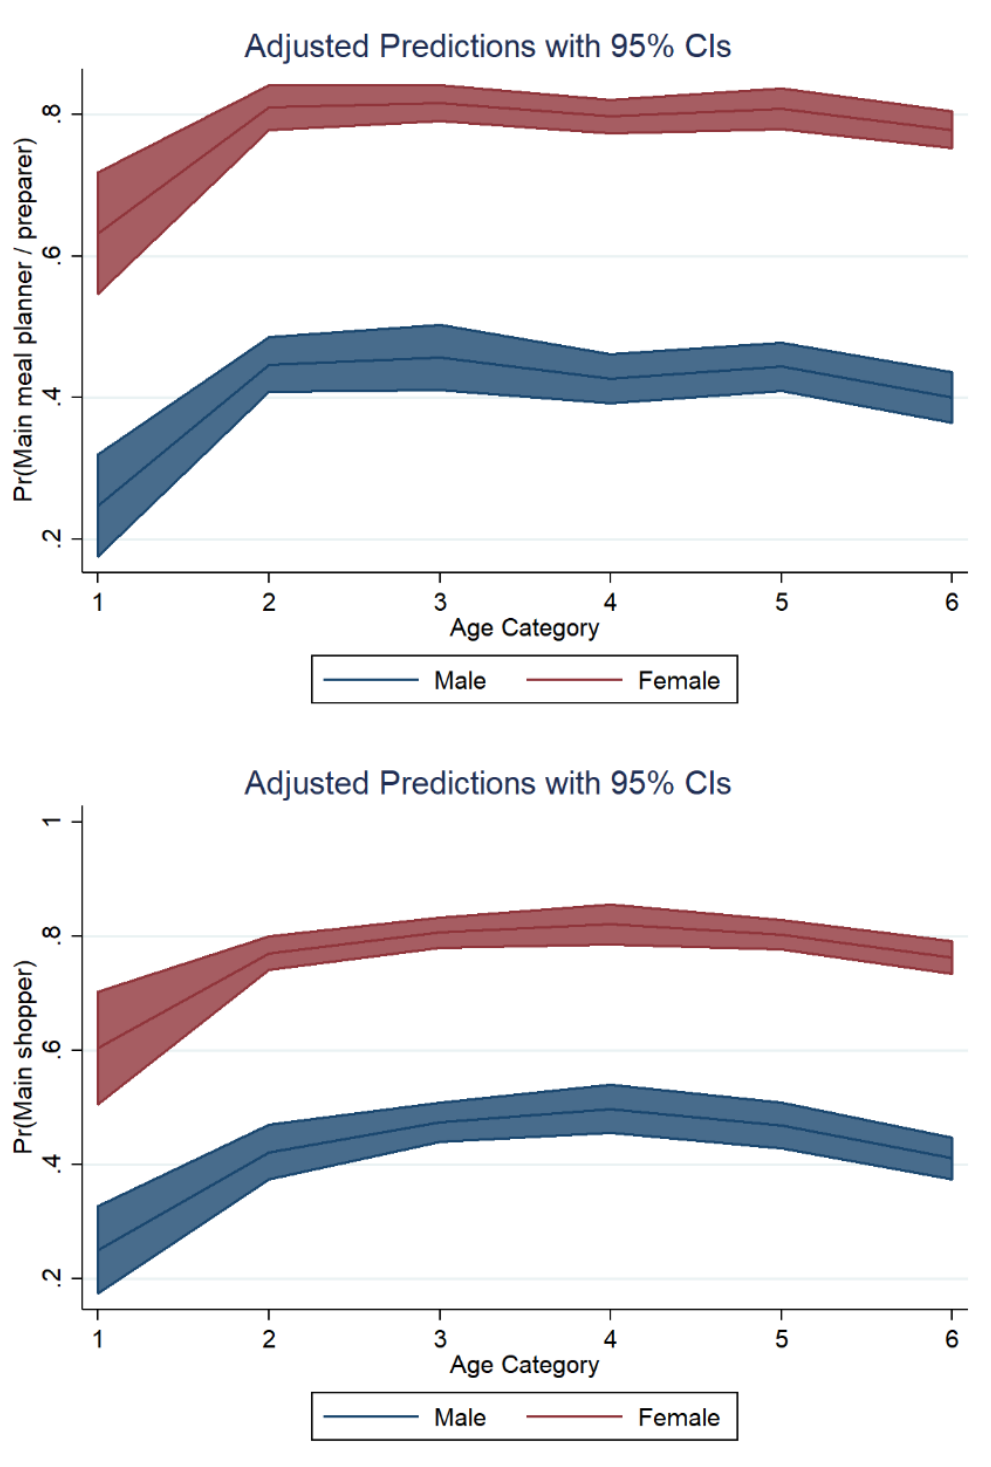
Figure 5. Main meal preparer responsibility and food shopping responsibility: marginal adjusted predictions. Marginal adjusted predictions for both sexes in all possible age categories. Upper panel: main meal preparer responsibility; lower panel: main shopping responsibility.